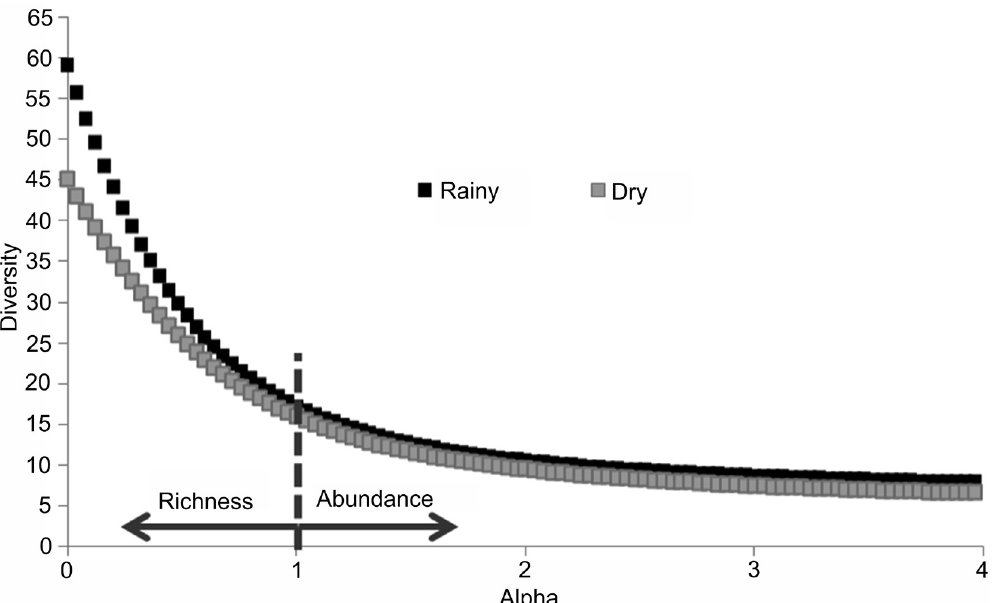
Figure 5. Diversity profile of the dry and rain seasons on the coast of Alagoas. Alpha = 1 Emphasizes the separation of richness and di- versity